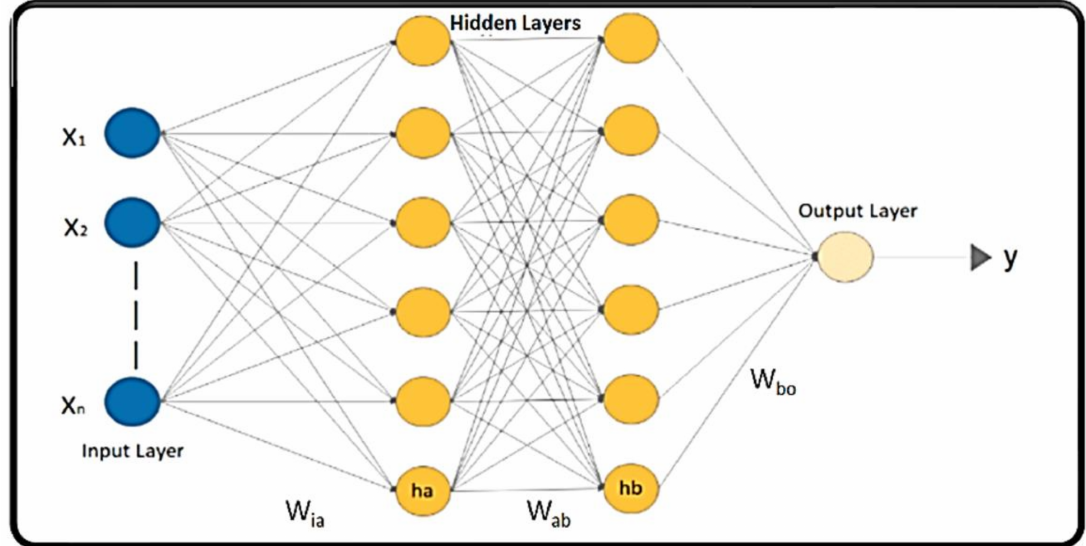
Figure 3. An illustration of a simple DNN with two hidden